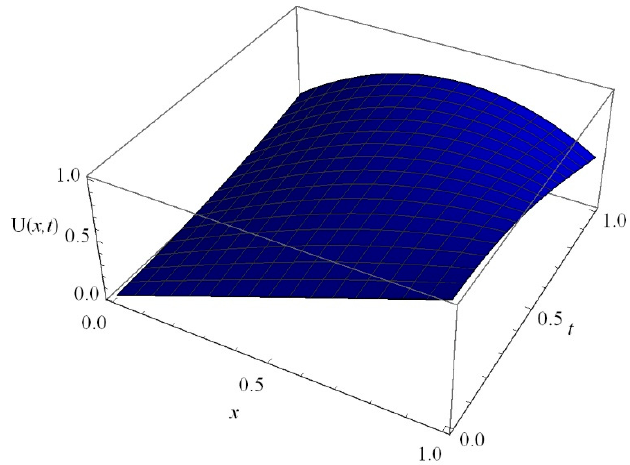
Figure 8. The graph of U ( x , t ) versus depth x and time t for Equation (37).